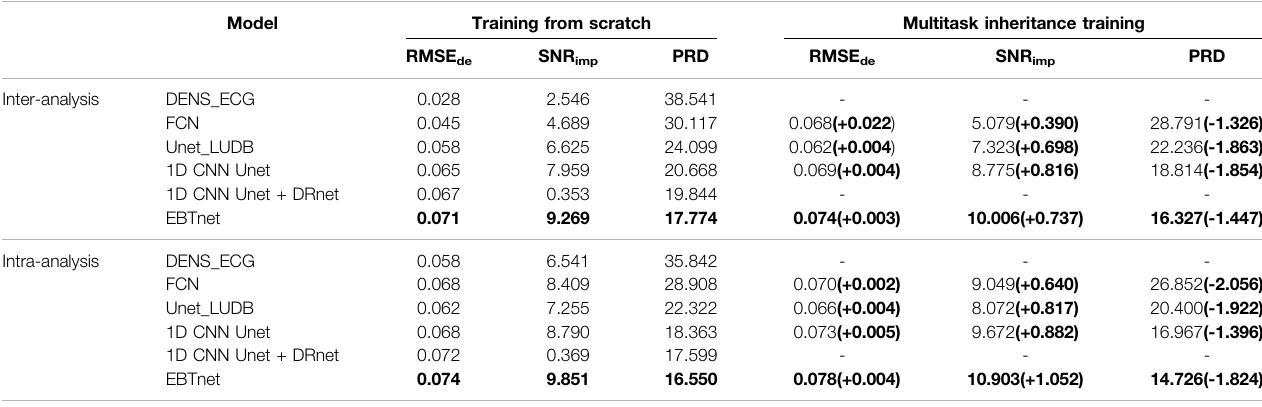
TABLE 2 | The comparison results of denoising models.